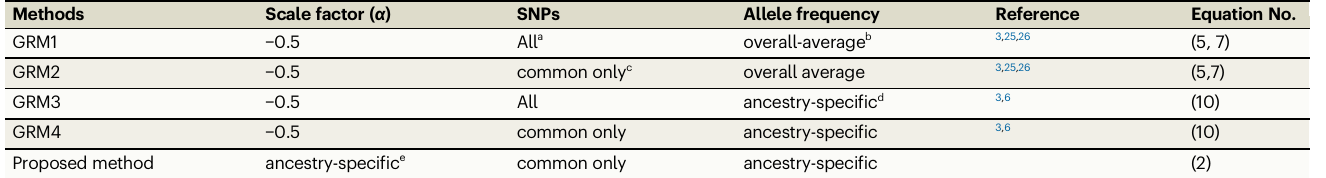
Table 1 | Four existing methods to estimate cross-ancestry genetic correlation, compared to the proposed method